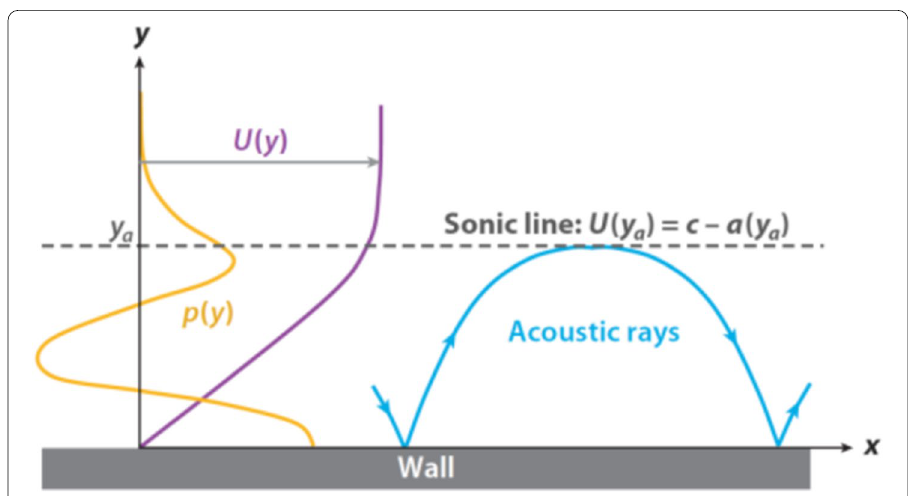
Fig. 7 Schematic diagram of acoustic modes in the hypersonic boundary layer